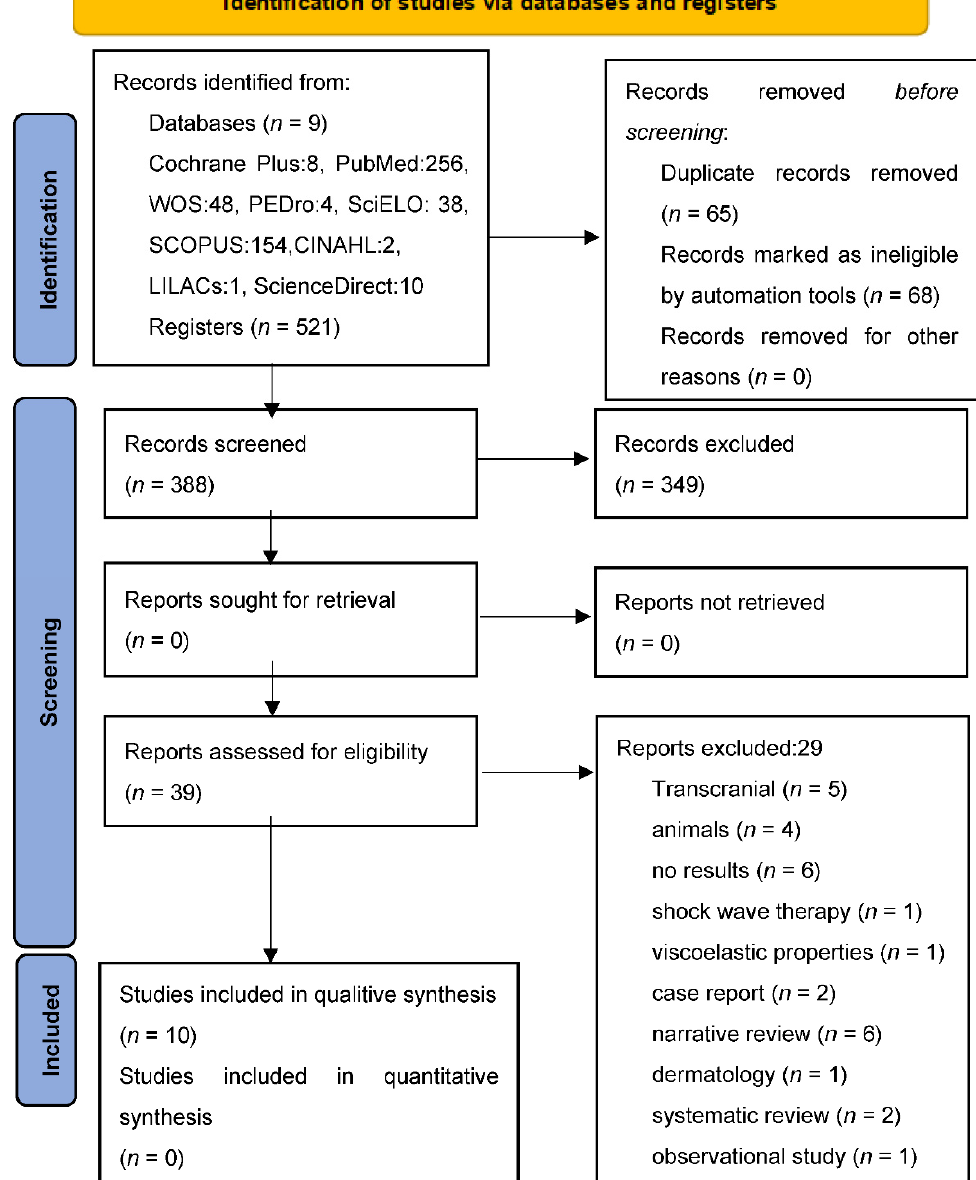
Figure 1. PRISMA 2020 flow diagram. From: Page MJ, McKenzie JE, Bossuyt PM, Boutron I, Hoffmann TC, Mulrow CD, et al. The PRISMA 2020 statement: an updated guideline for reporting systematic reviews. BMJ 2021;372: n 71. doi: 10.1136/bmj.n71.